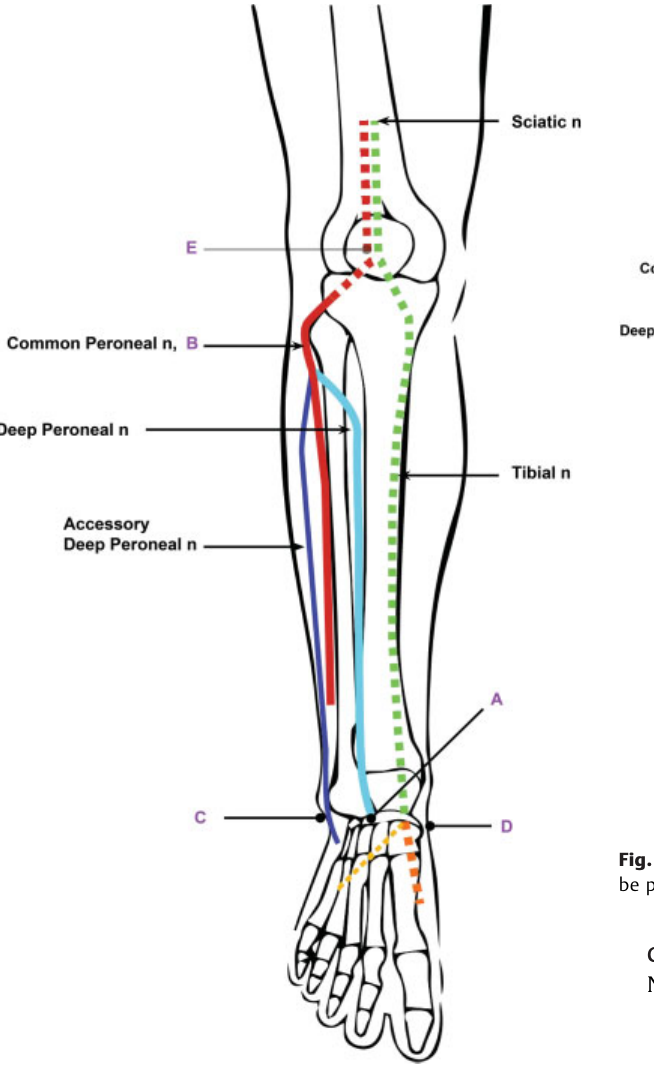
Fig. 2 Stimulation sites used to obtain a compound muscle action potential (CMAP) of the extensor digitorum brevis (EDB). ( A ) anterior ankle, ( B ) Lateral popliteal fossa, ( C ) lateral ankle, ( D ) medial ankle, tarsal tunnel, and ( E ) medial popliteal fossa.